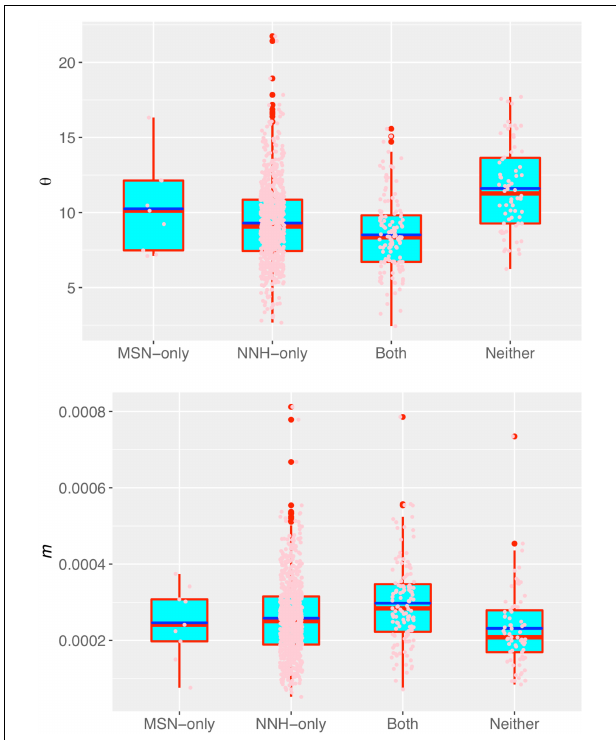
FIGURE 3 | The box plots of fundamental biodiversity number ( θ ) (the top) and the fundamental dispersal number (migration probability: m ) of the human DT microbiome, both estimated with the NNH model. Three standard summary statistics of the parameters ( θ ) and ( m ), including the first quartile (lower edge of the rectangle), median (the inside segment), third quartile (upper edge of the rectangle) were displayed, respectively. The “whiskers” above and below the box (rectangle) show the location of the minimum and maximum. The inter-quartile range (IQR) (showing the range of variation) is displayed by the height of the box; and the median shows the typical value. Outliers (<3 × IQR or >3 × IQR) are displayed outside the